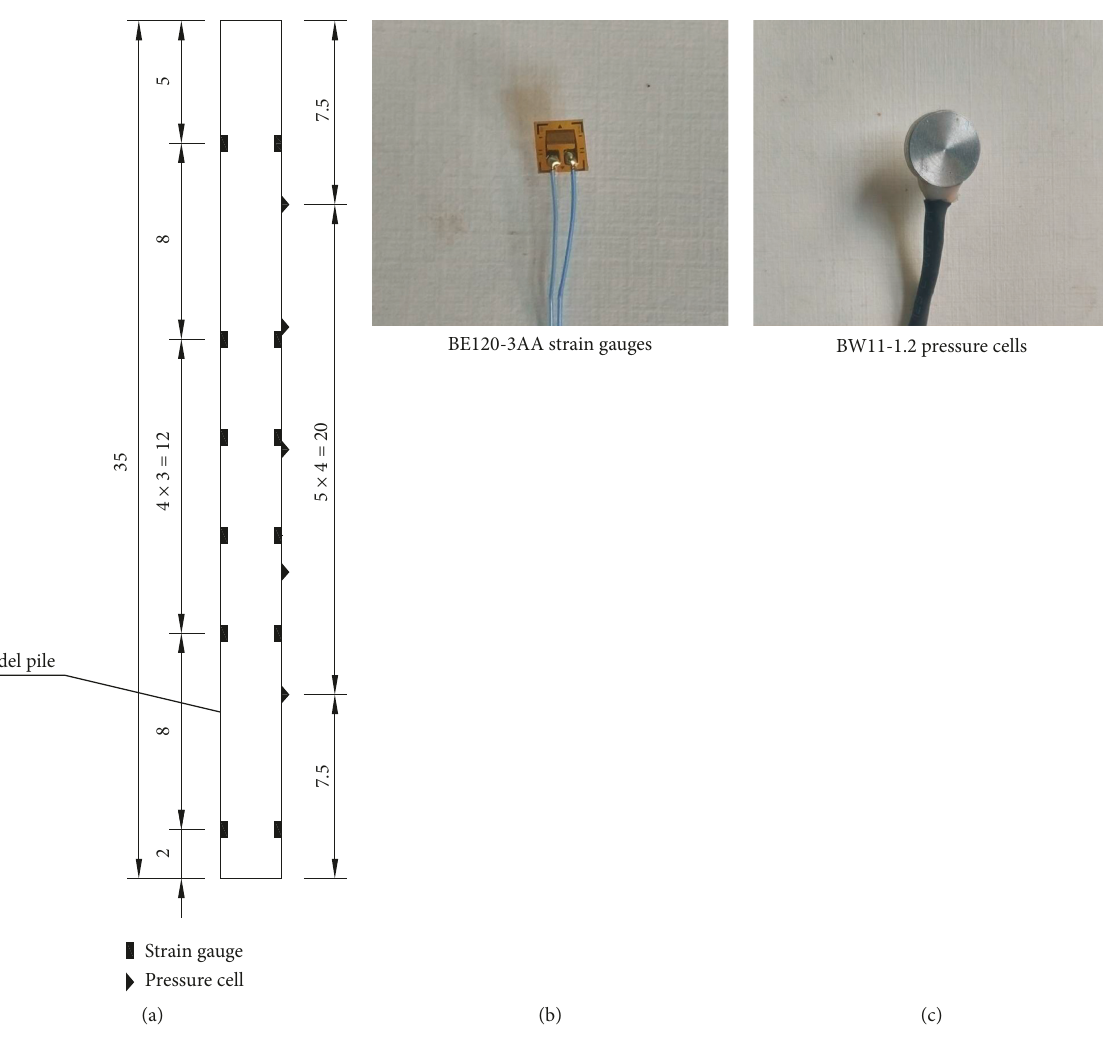
Figure 6: Placement of the strain gauges and the soil pressure cell (unit: